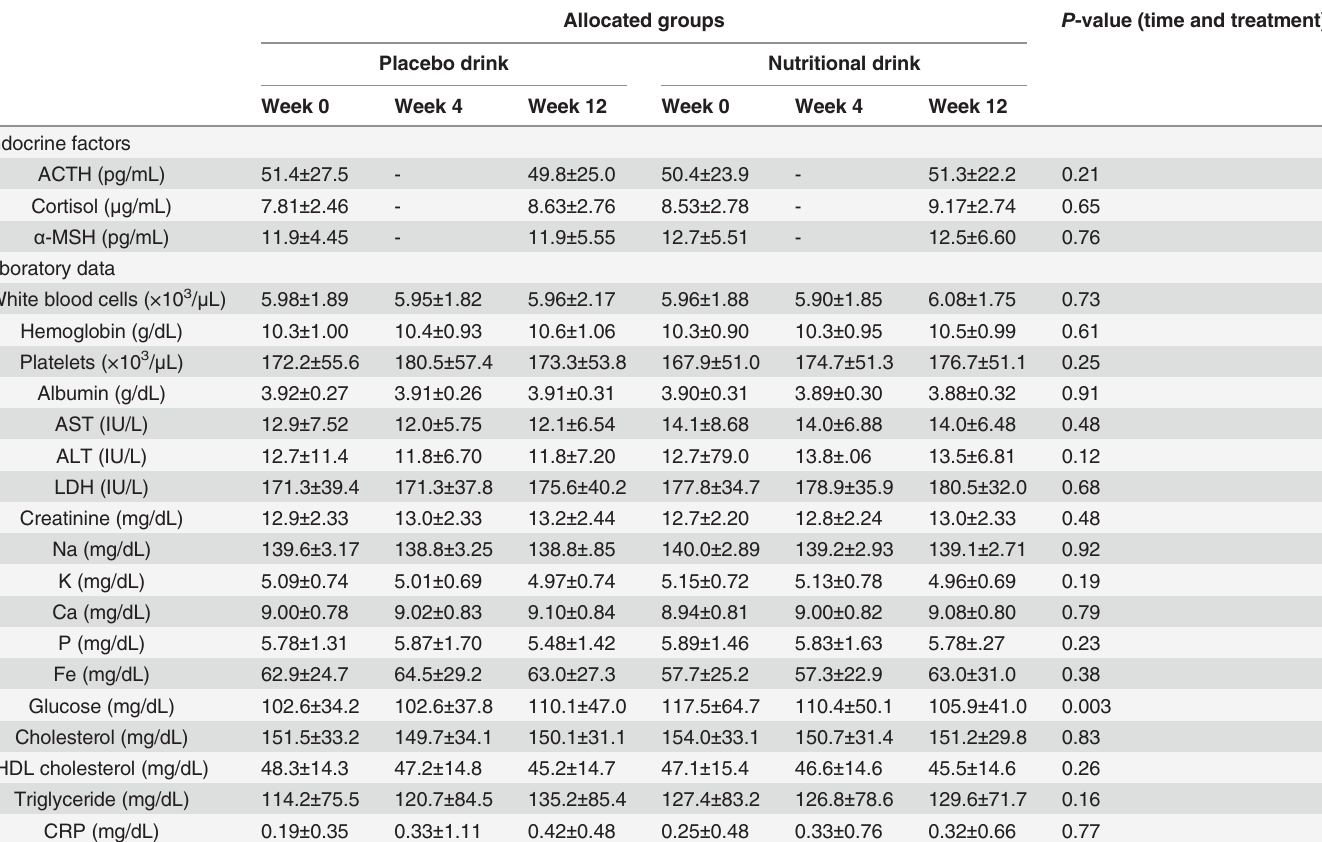
Table 3. Changes in HRV, endocrine function and laboratory data throughout the clinical trial. Allocated groups P -value (time and